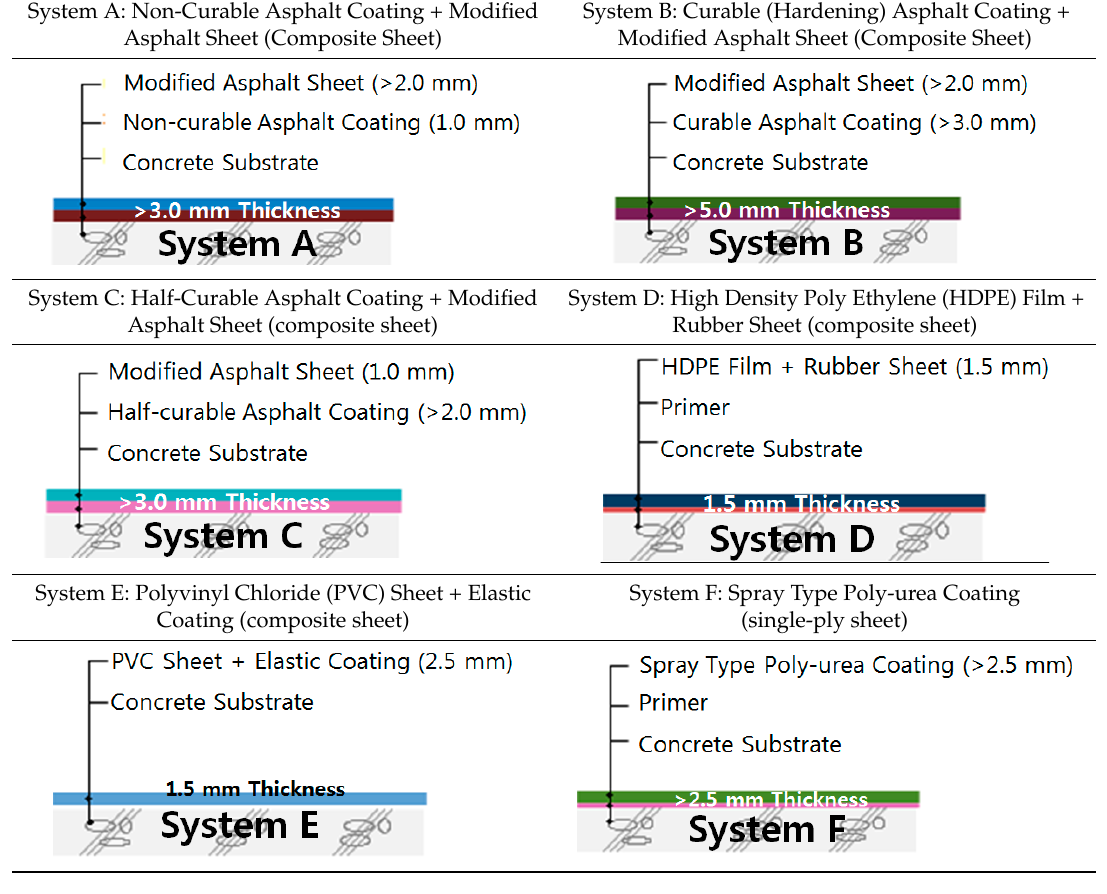
Table 1. Waterproofing membranes system installation layout on substrate surface (exposed).